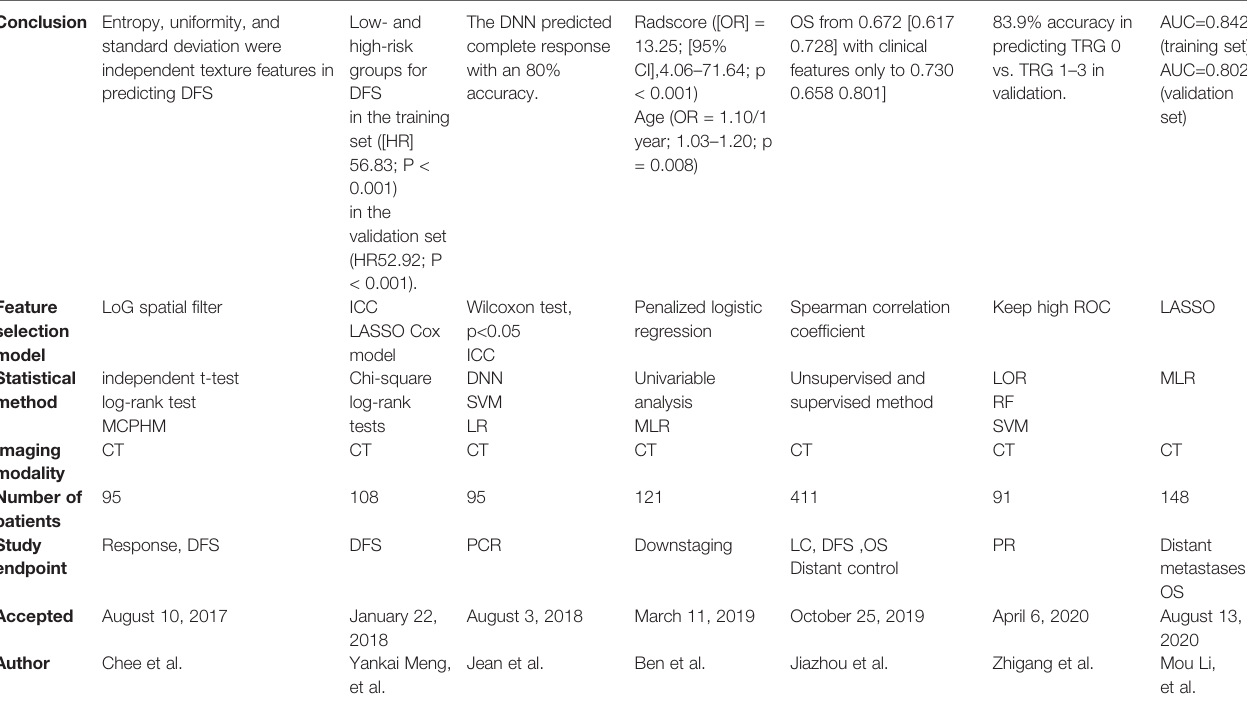
TABLE 1 | Summaries of selected locally advanced rectal cancer (LARC) radiomics studies (CT). Conclusion Entropy, uniformity, and standard deviation were independent texture features in predicting